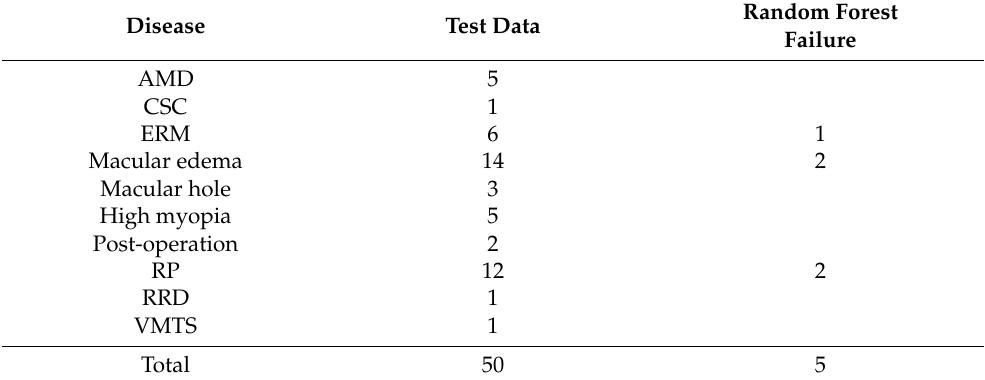
Table 2. Failure data in the random forest model. Disease